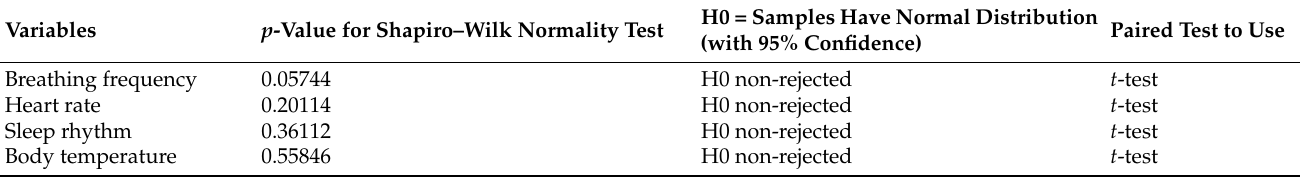
Table 13. Normality test for male subjects and the corresponding paired test used.